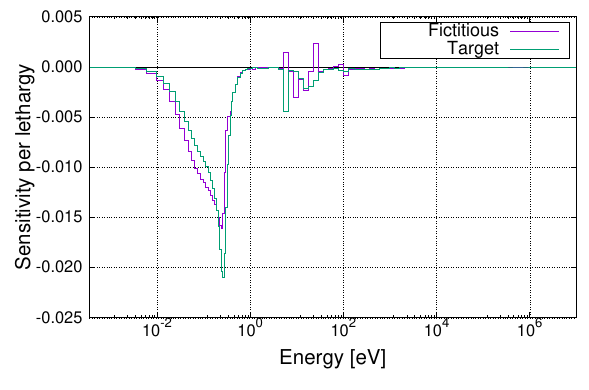
Figure 6. Sensitivities of target and fictitious parameters to Pu- 241 capture cross section in Case 4